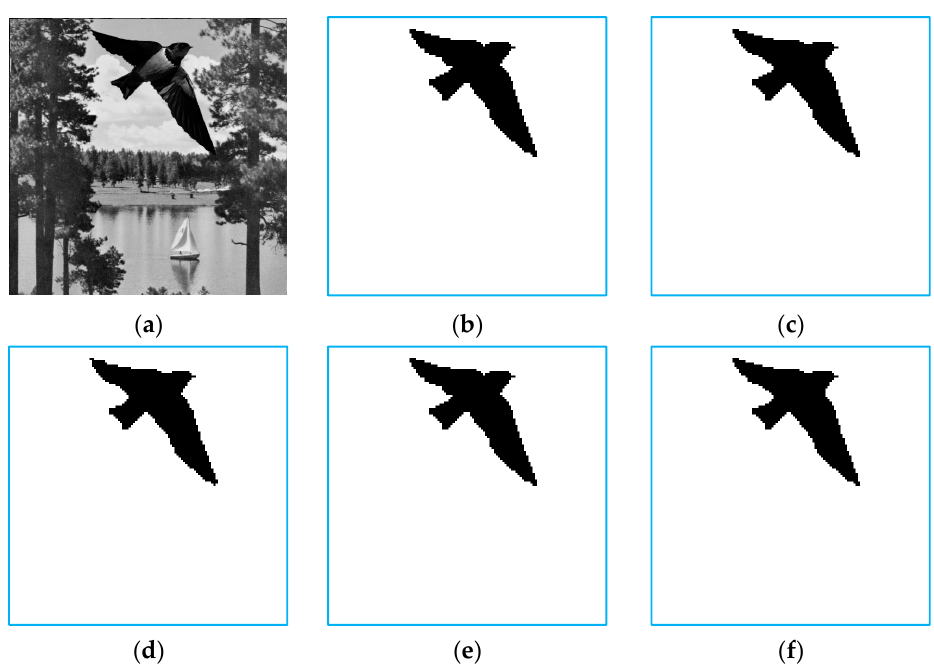
Figure 7. The tampered and detection results of [25–27] and the proposed method. ( a ) The tampered